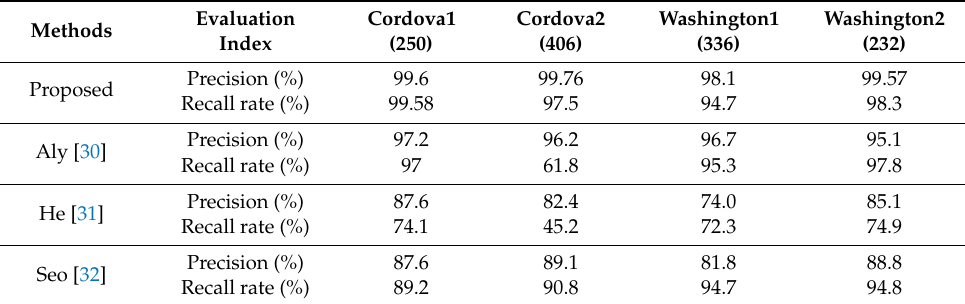
Table 2. Detection result comparison.